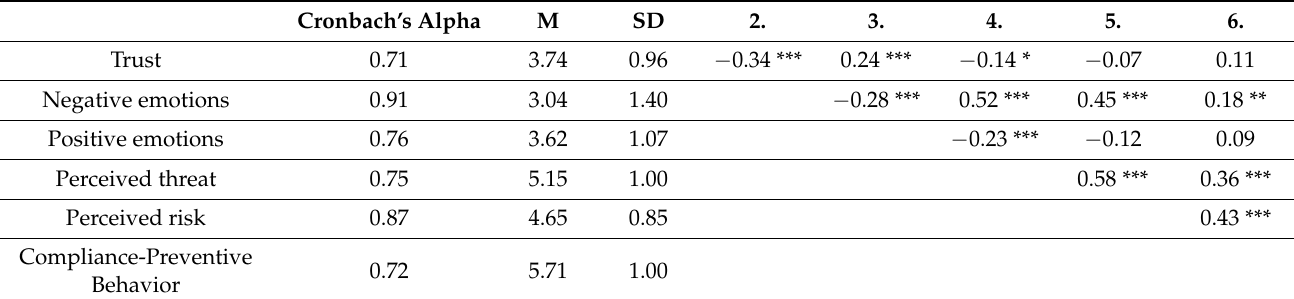
Table 2. Means, standard deviations, and intercorrelations for the study’s variables ( N = 200). Cronbach’s